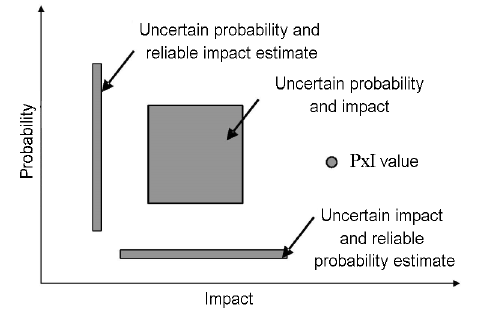
Fig. 1 . Comparison of “minimalist” view (adapted from Chapman 2006 ) with P-I